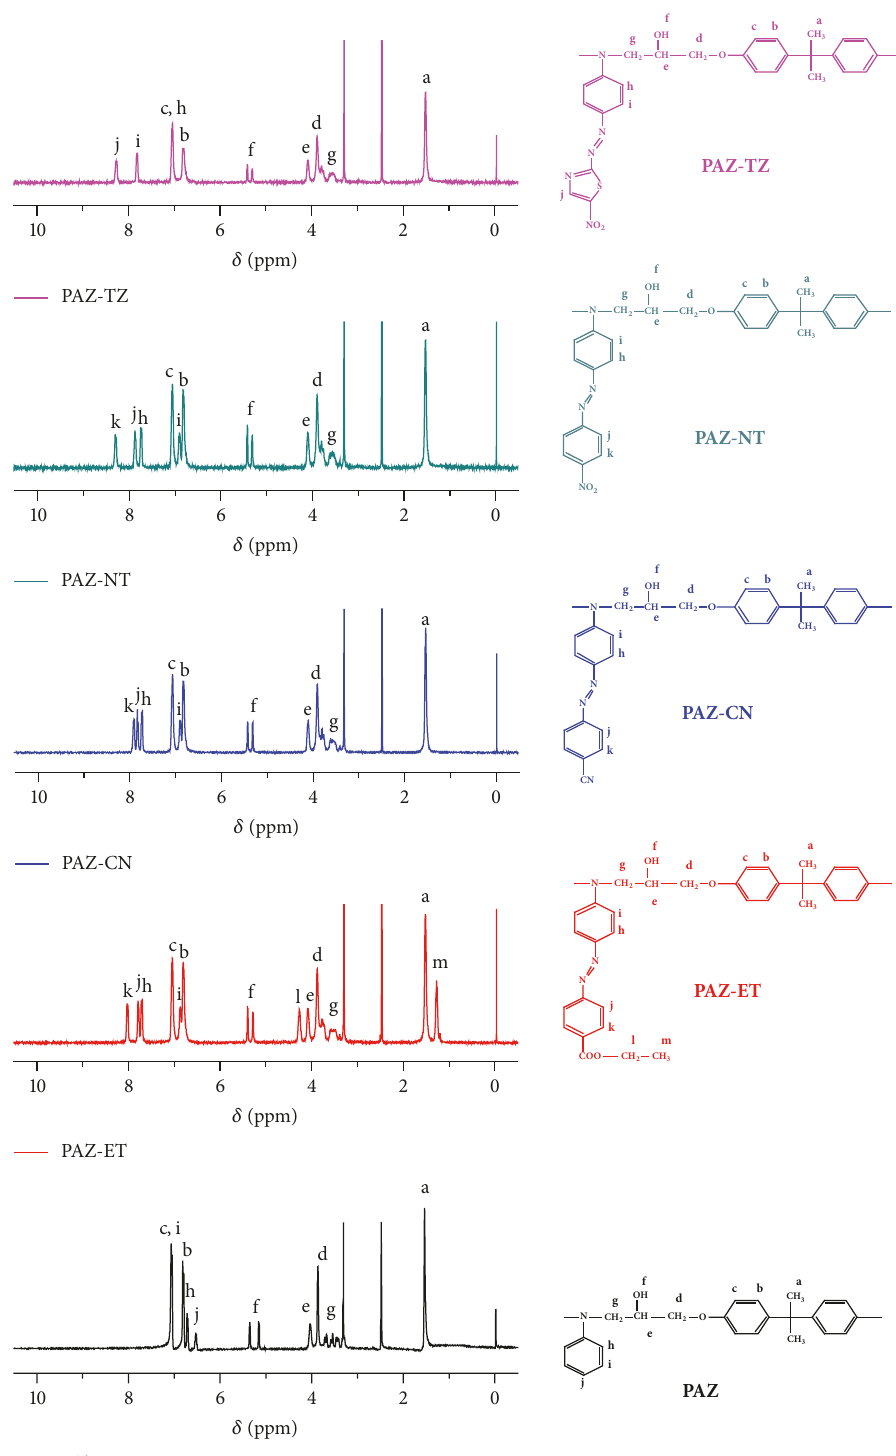
Figure 2: 1 H NMR spectra the precursor and the azo